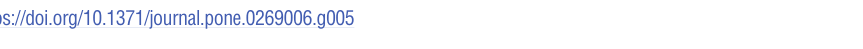
Fig 5. Cost-effectiveness acceptability curve (CEAC) for the conventional pharmacotherapy + exenatide in PD with